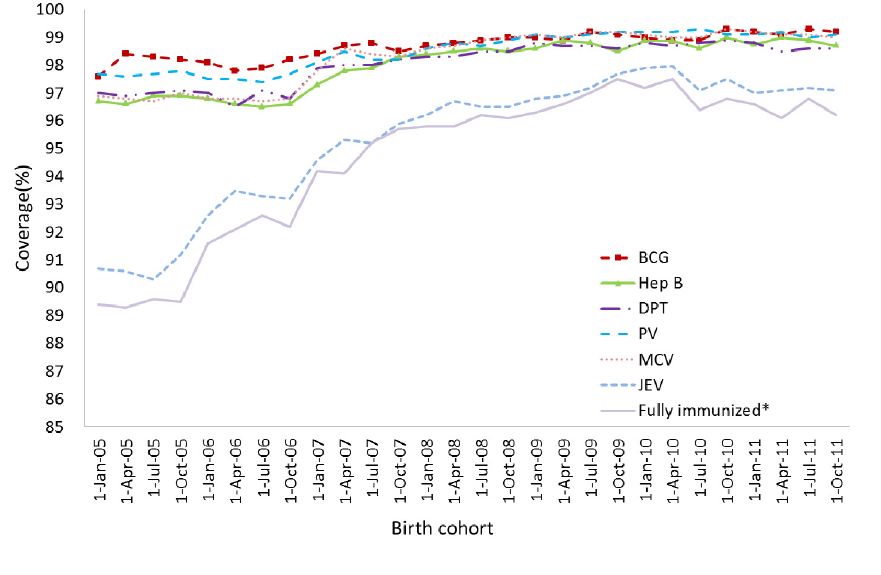
Figure 2. Trends in vaccination coverage estimates for individual vaccines at 24 months of age ( ≥ 4 doses of DPT, ≥ 3 dose of Hep B and PV, ≥ 2 dose of MCV and MPV-A, ≥ 1 dose of BCG, JEV, Hep A, “Fully immunized”), by 3-month birth cohorts born between 1 January 2005 to 31 December 2010. Coverage assessment date was 12 months after the last birth date of each